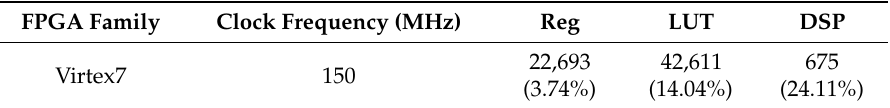
Table 3. Hardware utilization.